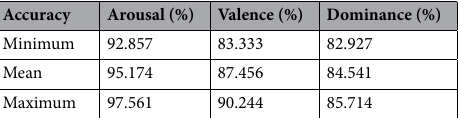
Table 5. Minimum, mean and maximum accuracy of feature fusion-based XGBoost